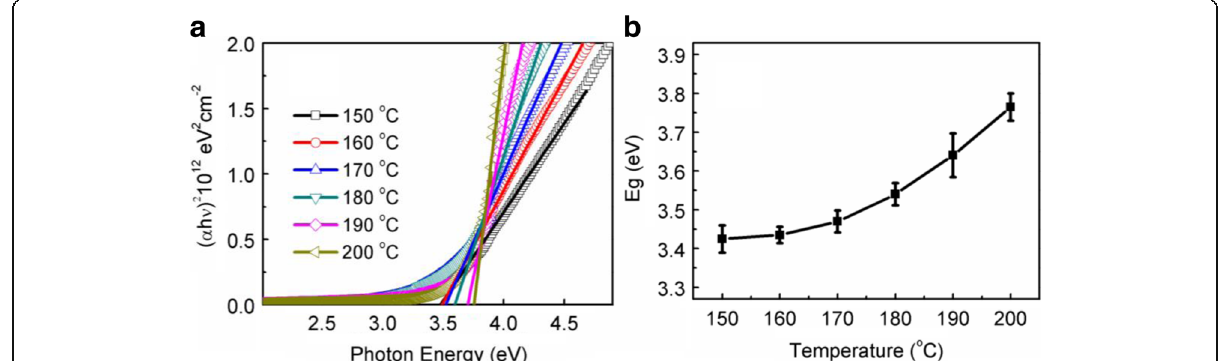
Fig. 5 a Plotting of ( α h ν ) 2 vs photon energy for the In 2 O 3 films deposited at different temperatures; b dependence of the extracted band gap (E g ) of In 2 O 3 on deposition temperature